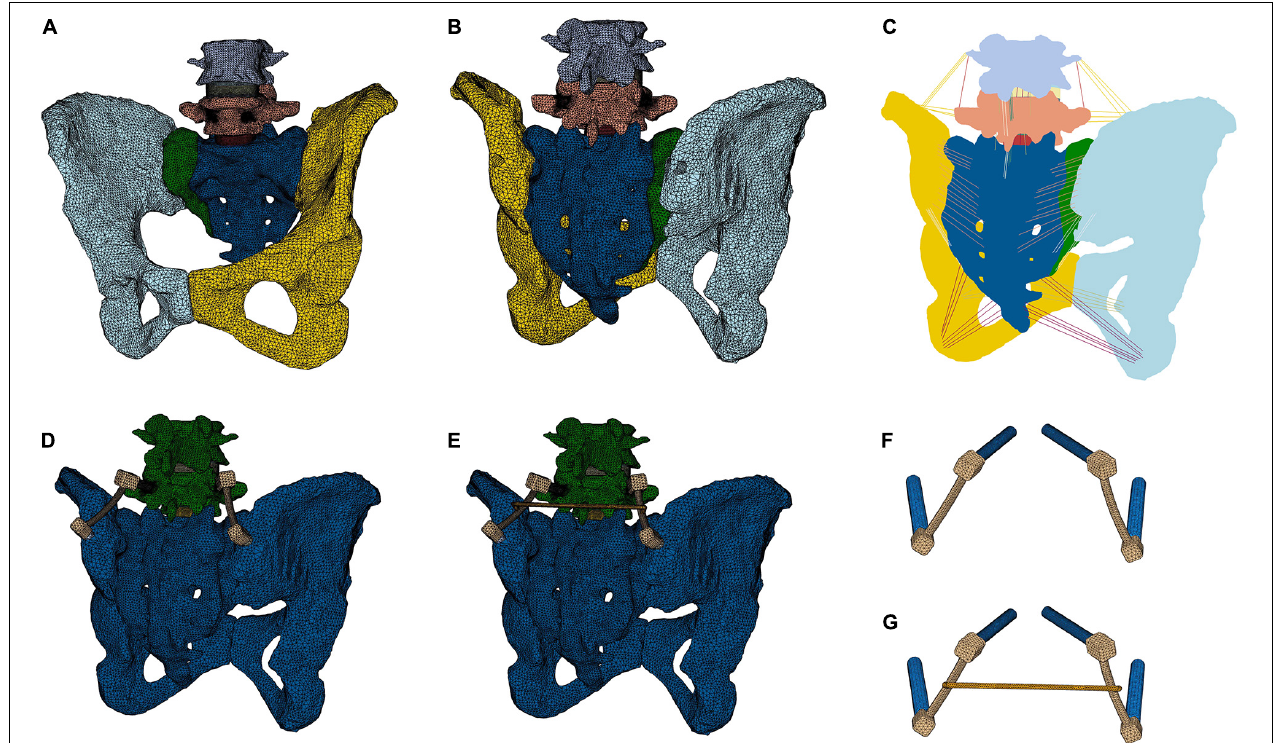
FIGURE 1 | Creation of a finite element model of the lumbopelvic area. The view from anterior (A) and posterior (B,C) and all ligamentous connections are demonstrated (C) . A lumbopelvic stabilization device from L5 to the Os ilium without (D,F) and with a cross connector (E,G) was modeled.